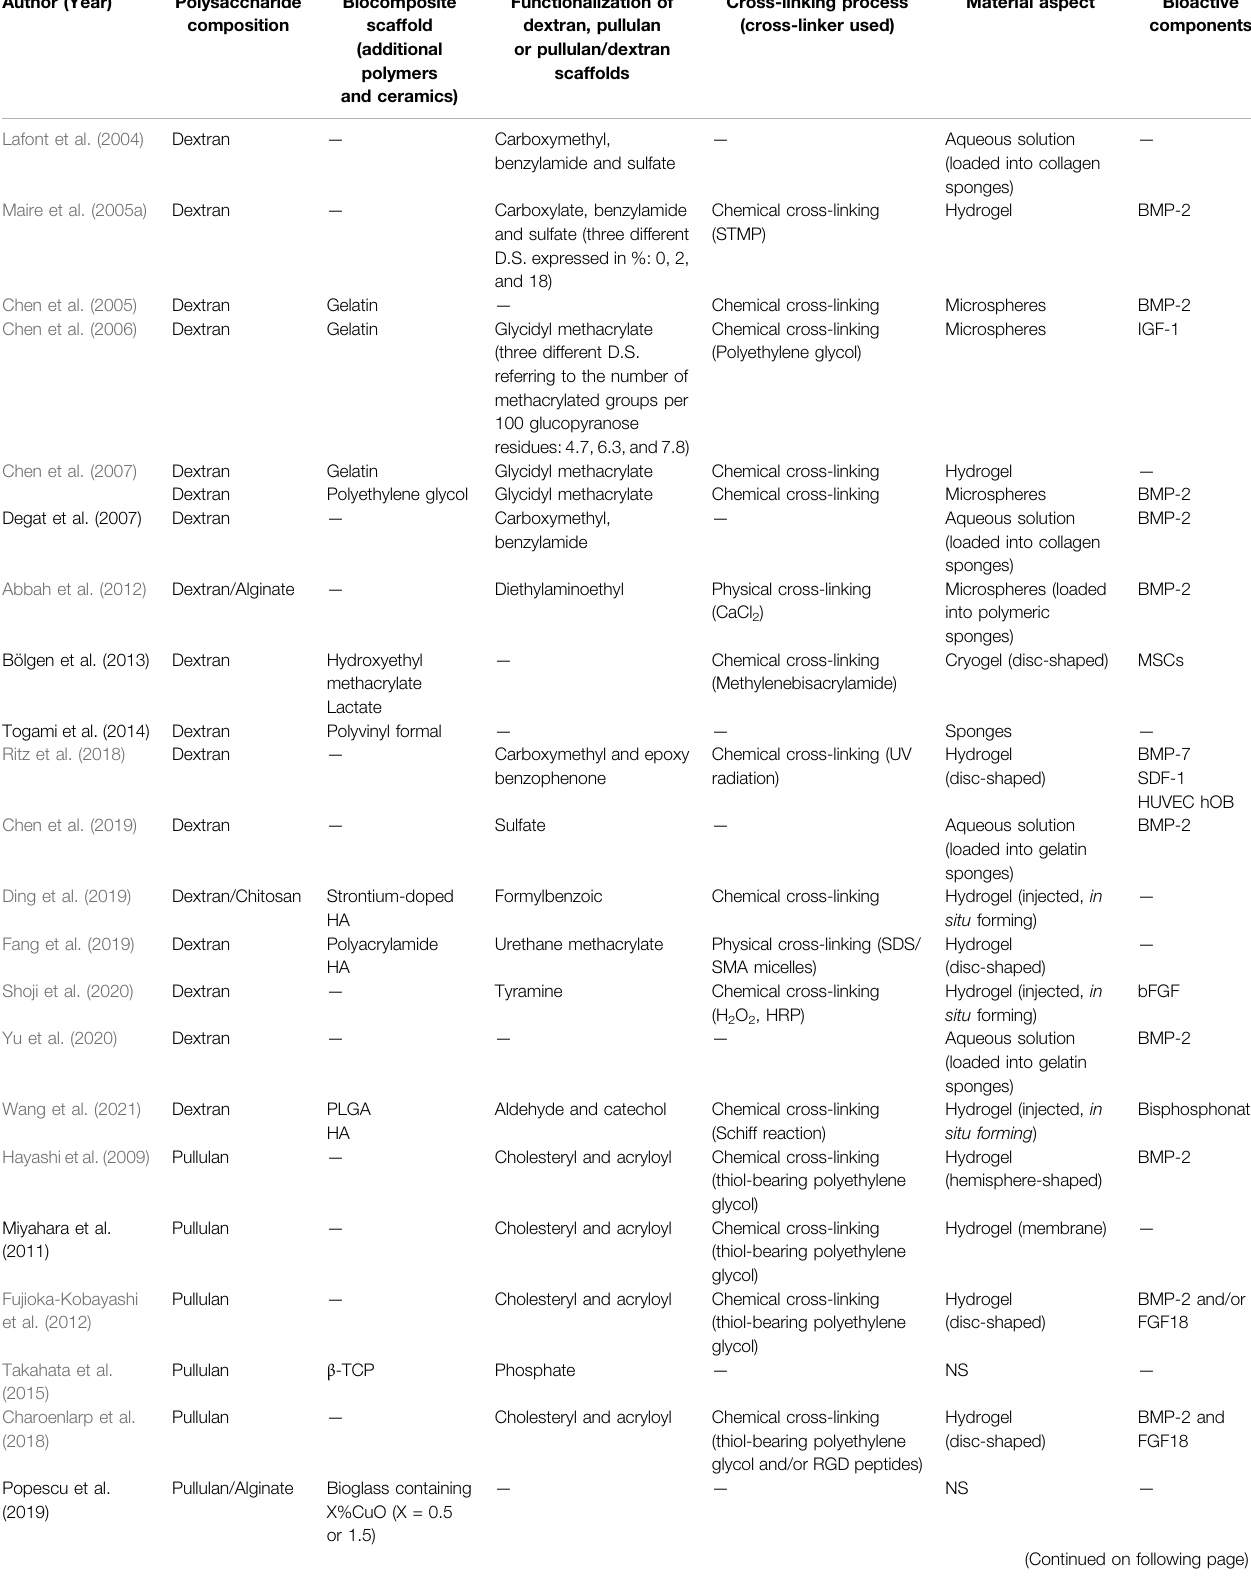
TABLE 1 | Characterization of scaffold used in the included